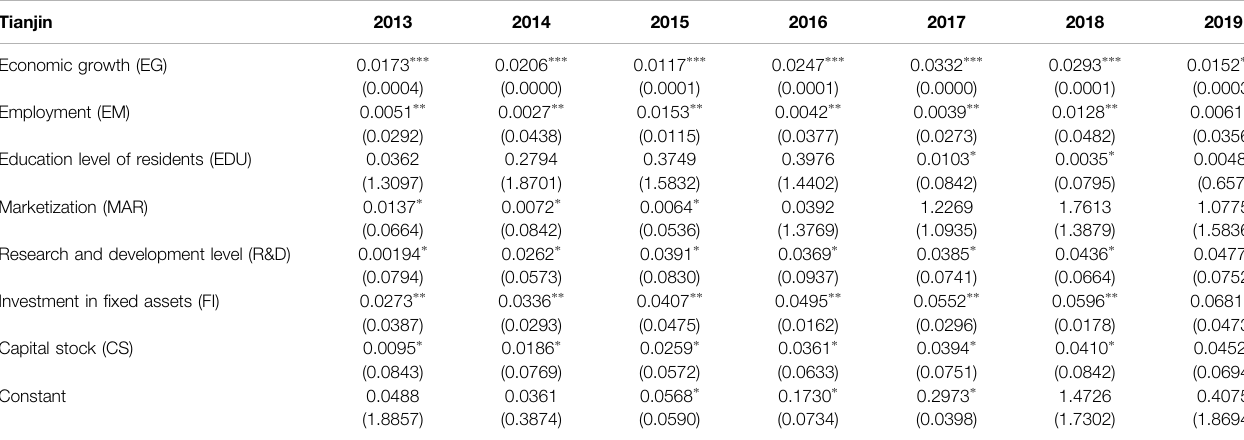
TABLE 8 | Driving force of Tianjin health tourism industry